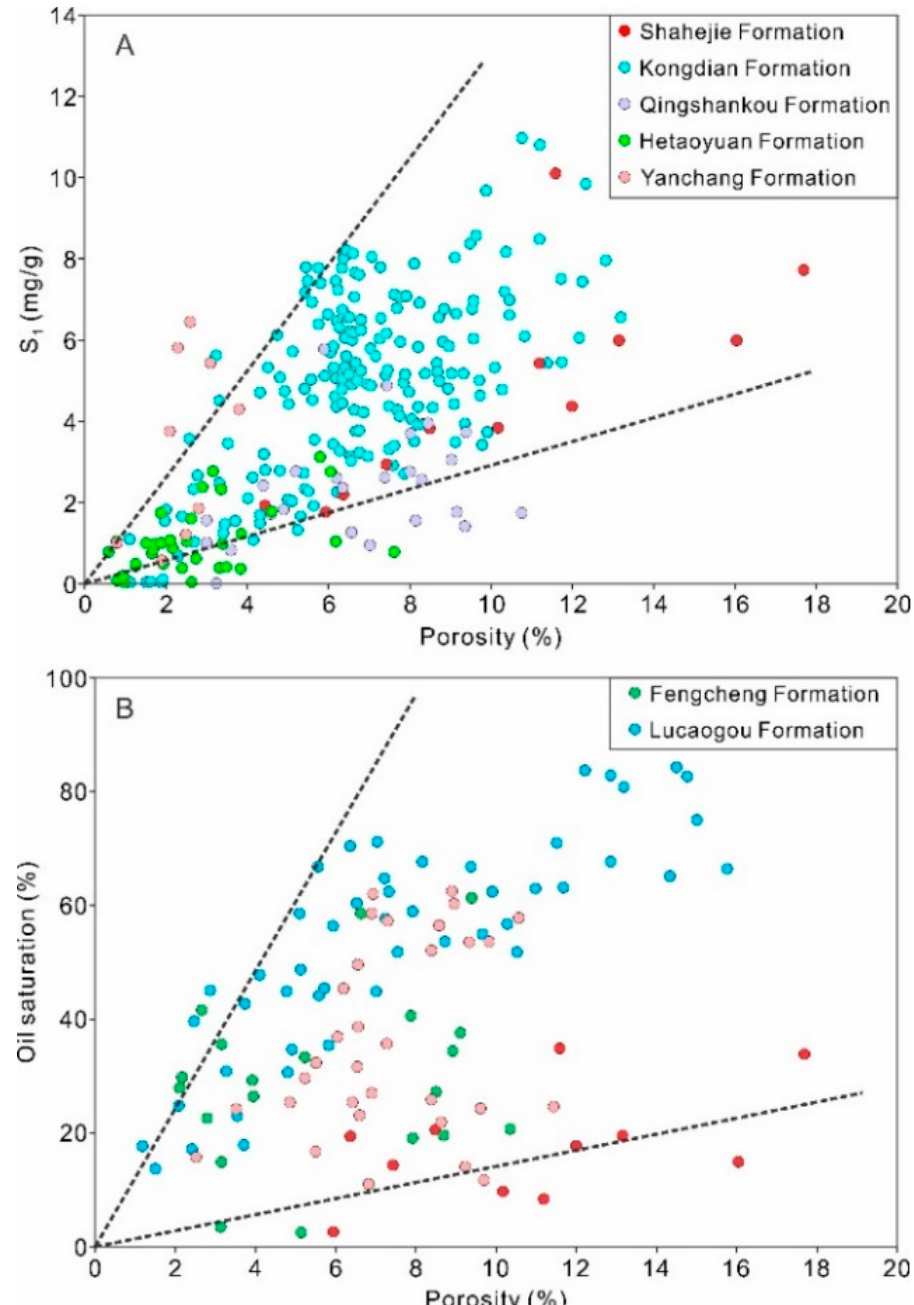
Figure 3. The relationship between porosity and S 1 ( A ) and oil saturation ( B ). Date from [46,79,98–100].